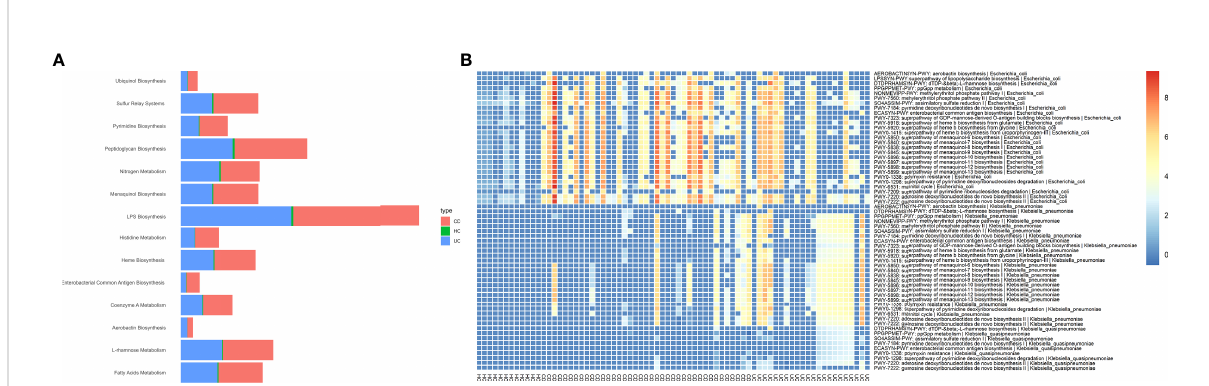
FIGURE 3 Potentially associations between metabolic pathways encoded by Enterobacteriaceae species and CD and UC as determined by Wilcoxon rank- sum test. To illustrate the enrichment of putatively species-speci fi c pathways that were altered in CD and UC, we speci fi cally focused on the subset of associations that were statistically signi fi cant ( P <0.05), including E. coli , K. pneumoniae , and K. quasipneumoniae -related pathways. All associations were representative of positive correlations, i.e. , were elevated in both CD and UC patients compared to HCs. (A) The relative abundance of major microbial biosyntetic pathways that were involved in a positive association with the CD and UC cohorts. (B) The heat map represents metagenomically differences in the abundance of species-speci fi c metabolic pathways in the intestinal bacteria community of CD, UC, and HC